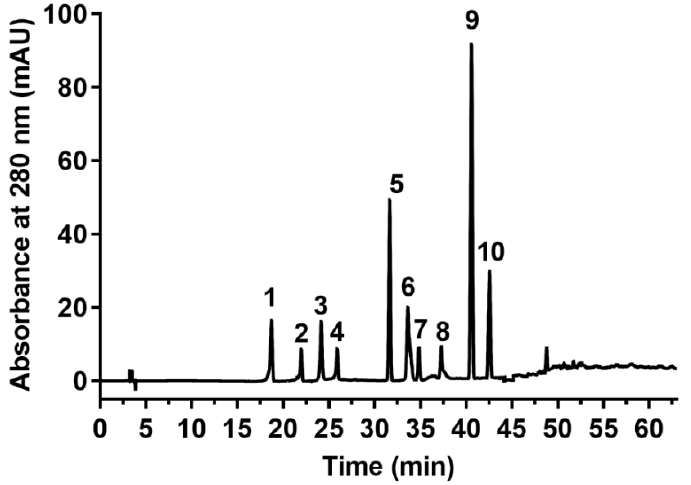
Figure 3. The chromatogram for the standards obtained by gradient elution on reversed phase C-18 column and Photo-Diode Array detector at 280 nm. Peak 1, protocatechuic acid; peak 2, catechin; peak 3, chlorogenic acid; peak 4, epicatechin; peak 5, ferulic acid; peak 6, coumarin; peak 7, rutin; peak 8, myricetin; peak 9, cinnamic acid; peak 10, genistein. mAU: miliabsorbance unit. Table 6. Phenolic profile of common bean extracts under optimal extraction condition.